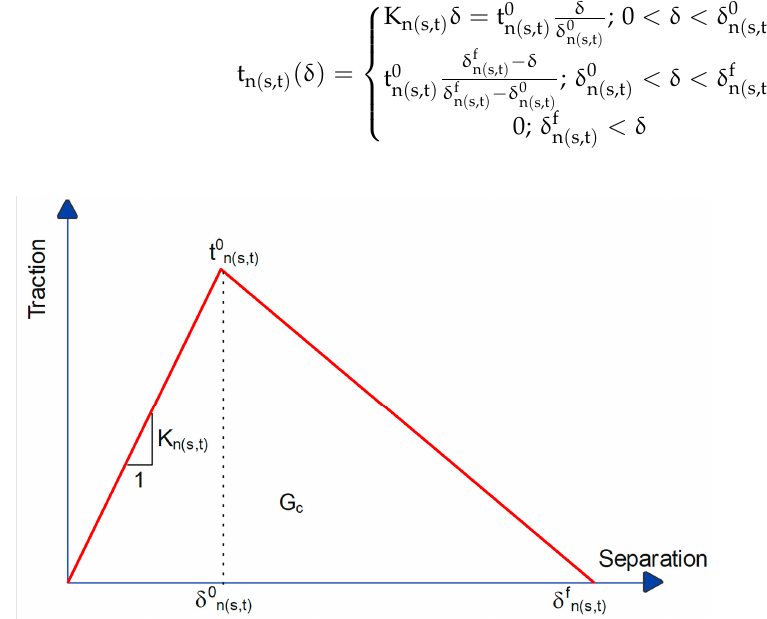
Figure 2. Linear traction ‐ separation response .